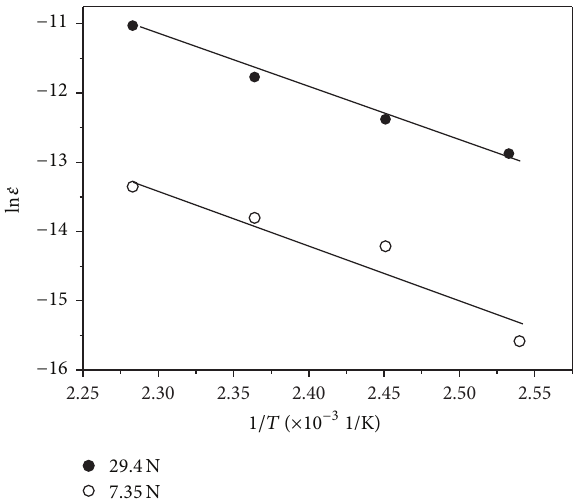
Figure 8: Correlation between tensile creep material constant and temperature.